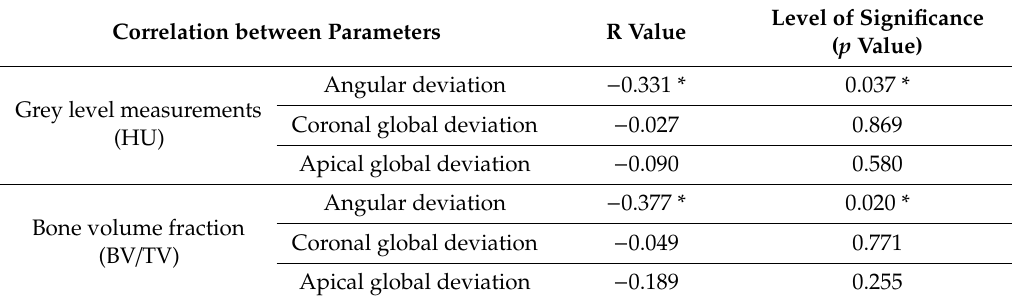
Table 2. Correlation statistics between the primary outcome variables and bone density